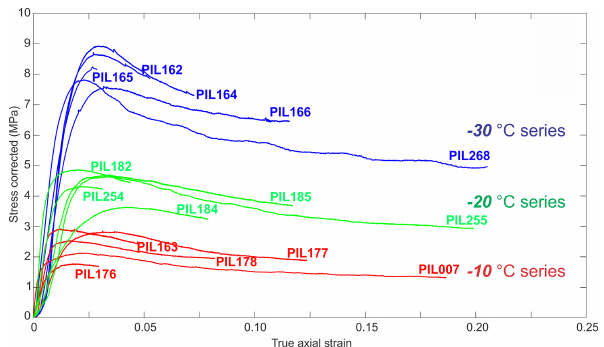
Figure 3. The stress–strain curves for all the deformed ice samples. The x axis is the true axial strain (Eq. 2). The y axis is the uniax- ial stress. The stress has been corrected for the change of sample cross-sectional area, assuming constant sample volume during the